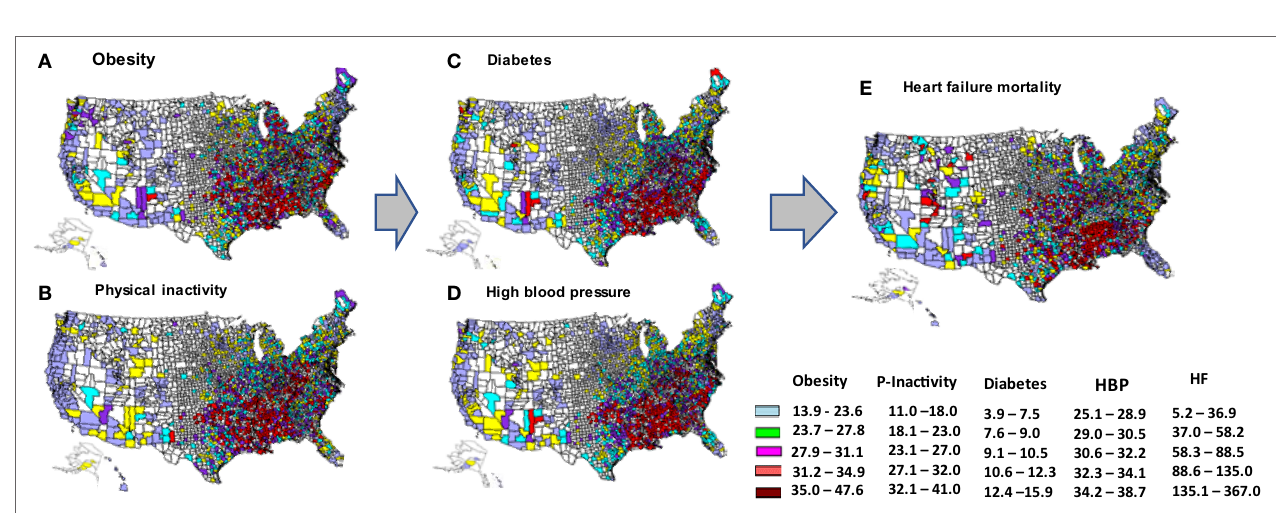
FigUre 2 | State-level variations in age-adjusted prevalence of obesity (a) , physical inactivity (B) , diabetes (c) , high blood pressure (HBP) (D) , and age-adjusted mortality from heart failure (HF) (e) , depicted by quintiles of each variable. The arrows represent a hypothesized pathway. (Note: the states of Alaska and Hawaii are shown on the left bottom in each map for the purpose of being presented in a figure. Please refer to a U.S. map for their exact location.)